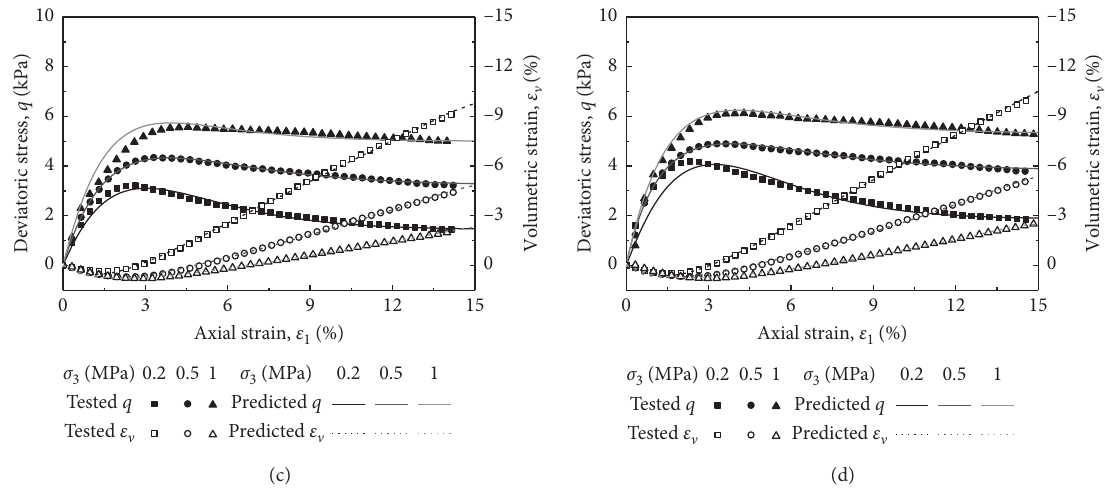
Figure 14: Predicted and experimental deviatoric stress-strain results of frozen coarse-grained materials: (a) T � − 2 ° C; (b) T � − 5 ° C; (c) T � − 10 ° C; (d) T � − 15 ° C.